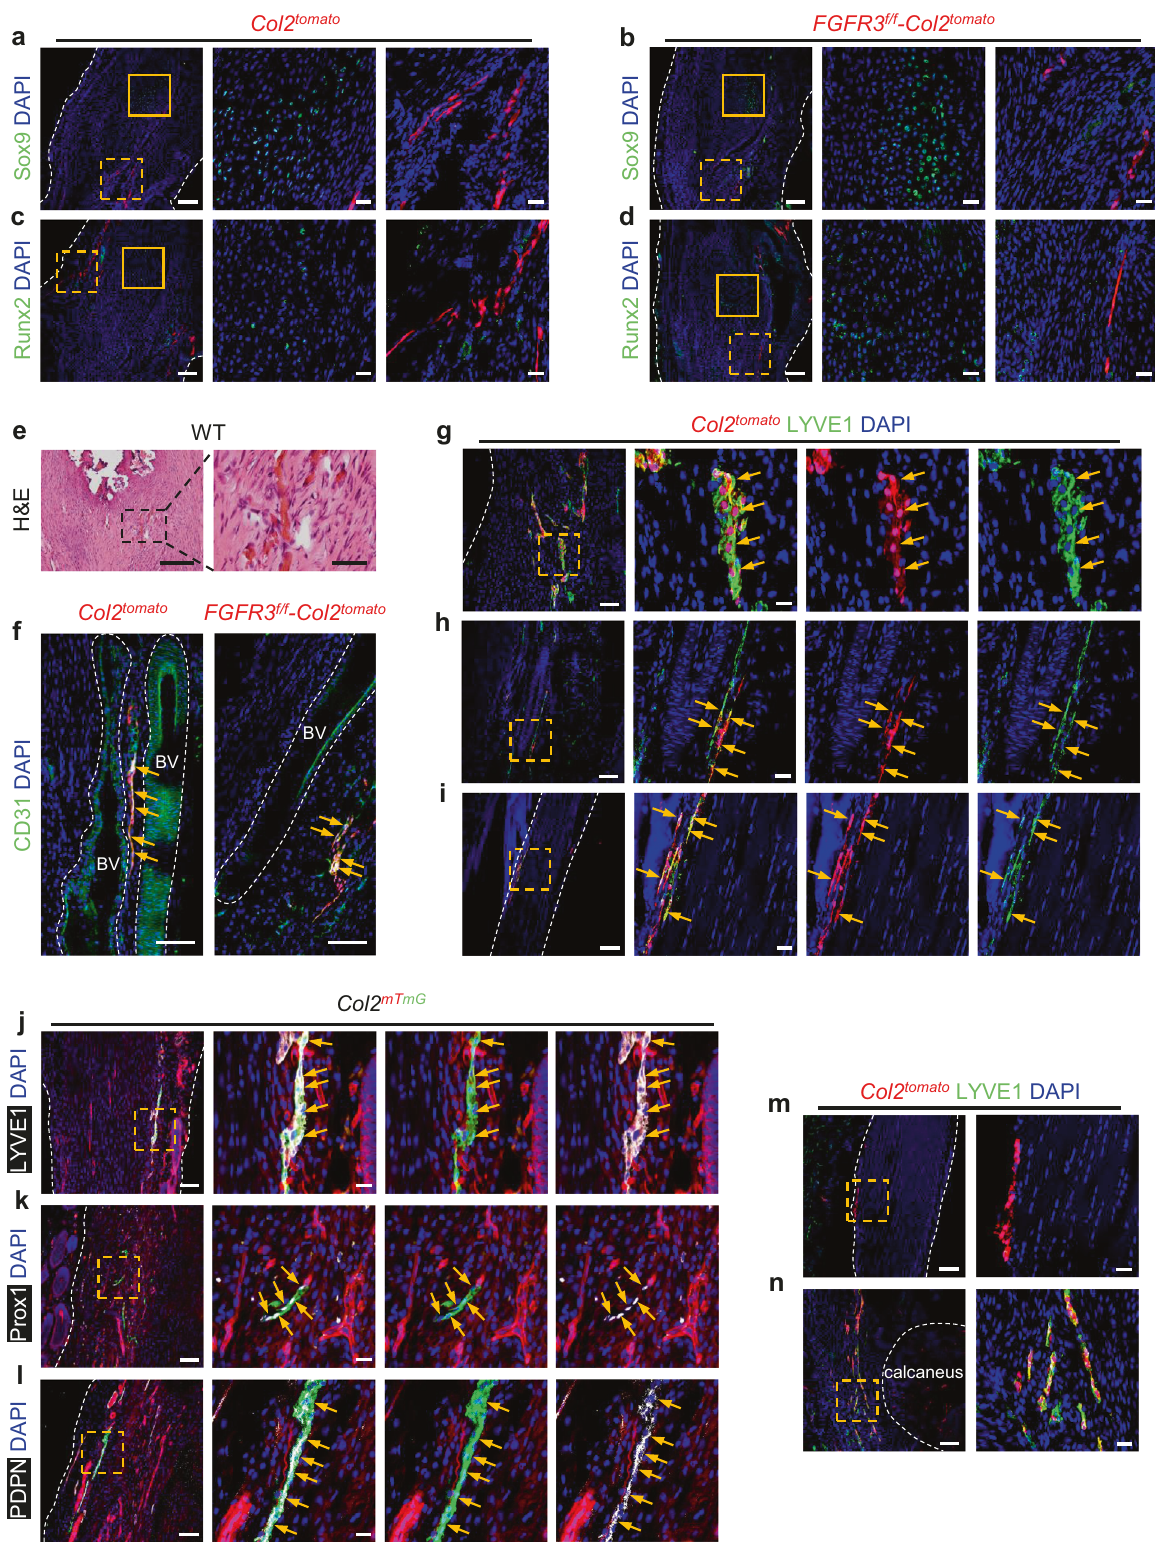
numbers of chondrocytes in the tendon of control mice, which were signi fi cantly increased in FGFR3 Prox1 mice (Fig. 3c – e). Immunohistochemical (IHC) data revealed signi fi cantly higher expressions of Sox9 and Osx in the HO lesions of FGFR3 Prox1 mice relative to FGFR3 f/f mice (Fig. 3f – i). Signi fi cantly increased HO volume was detected in FGFR3 Prox1 mice relative to